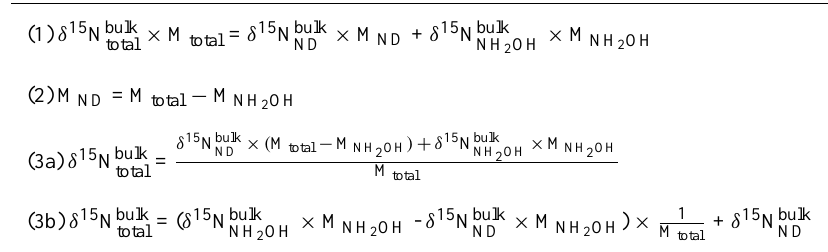
Table 1. Equations used to model the δ 15 N bulk N 2 O data in Fig.